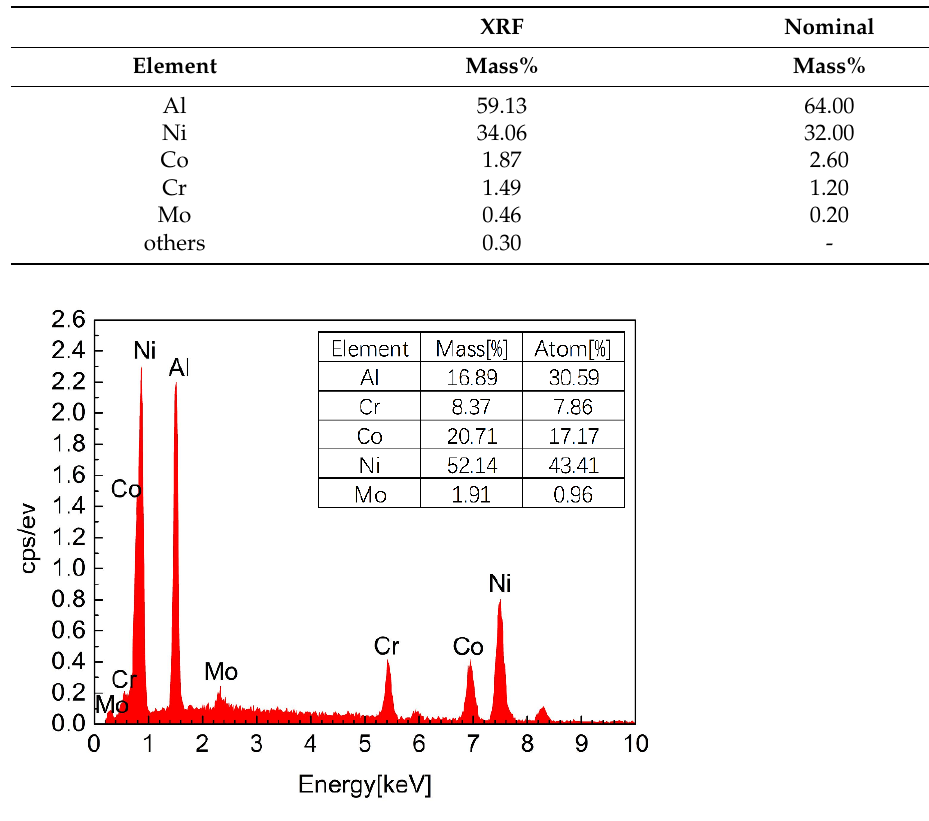
Figure 7. EDS spectrum of batch 3.